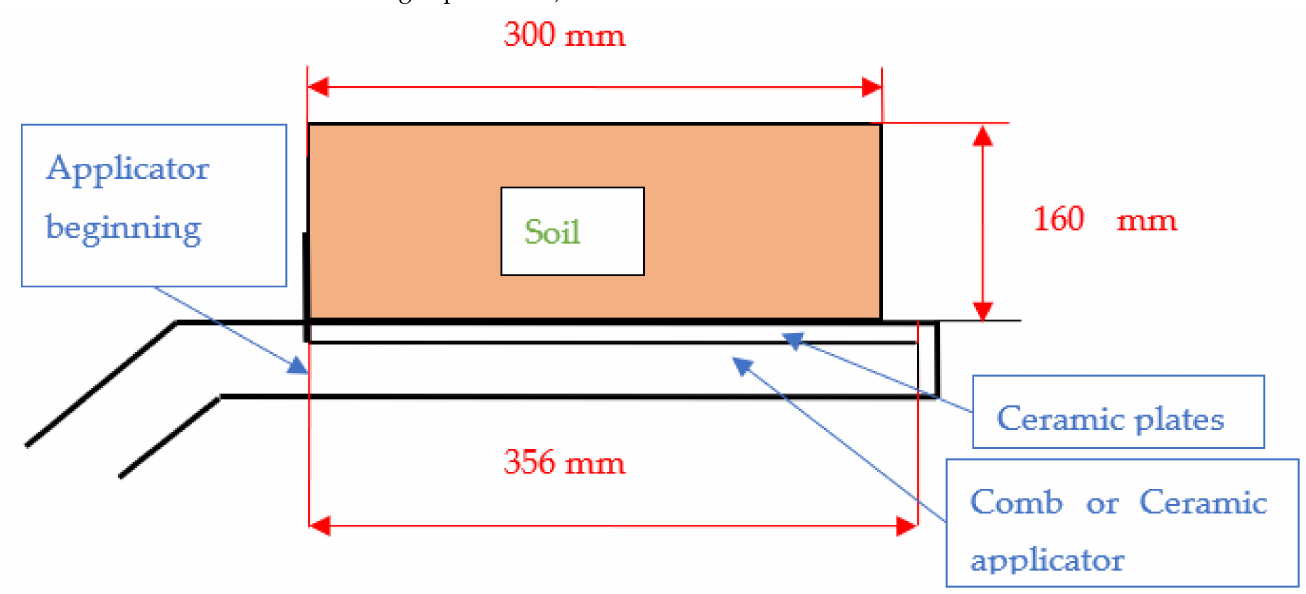
Figure 4. Schematic of applicator with soil in